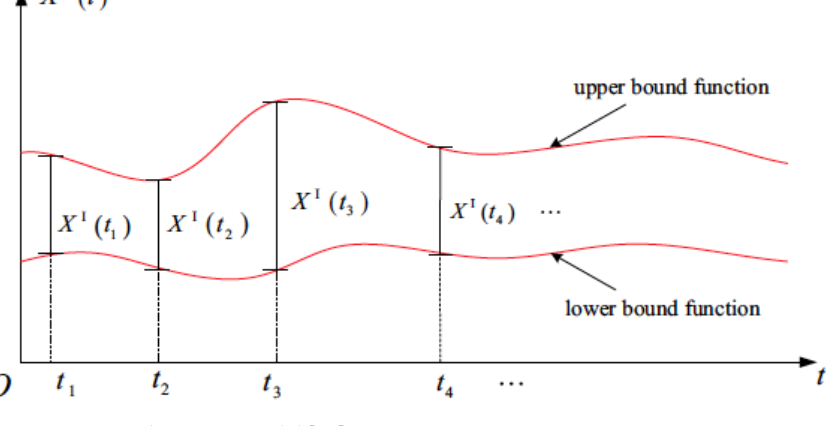
Figure 2. Interval process model